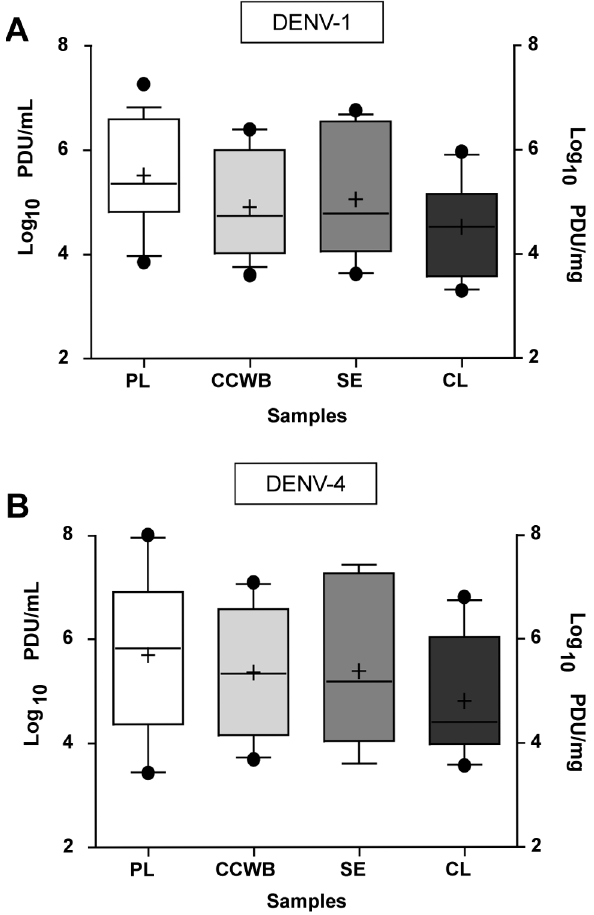
Fig 2. Mean DENV-1 and DENV-4 viral loads in blood components. A) DENV-1 and B) DENV-4 viral load averages observed in plasma (PL) (n = 29), the cellular component of whole blood (CCWB) (n = 29), serum (SE) (n = 21) and clots (CL) (n = 21) from samples from infected Puerto Rican blood donors, 2012 – 2013. Whiskers represent 10-90th percentile. Outliers are shown as black dots. Mean is shown as a “ + ” sign and median as a horizontal line inside the